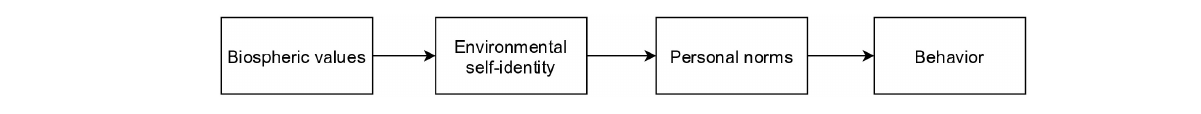
are not stable yet (Moshman, 1999; Wigfield et al.,